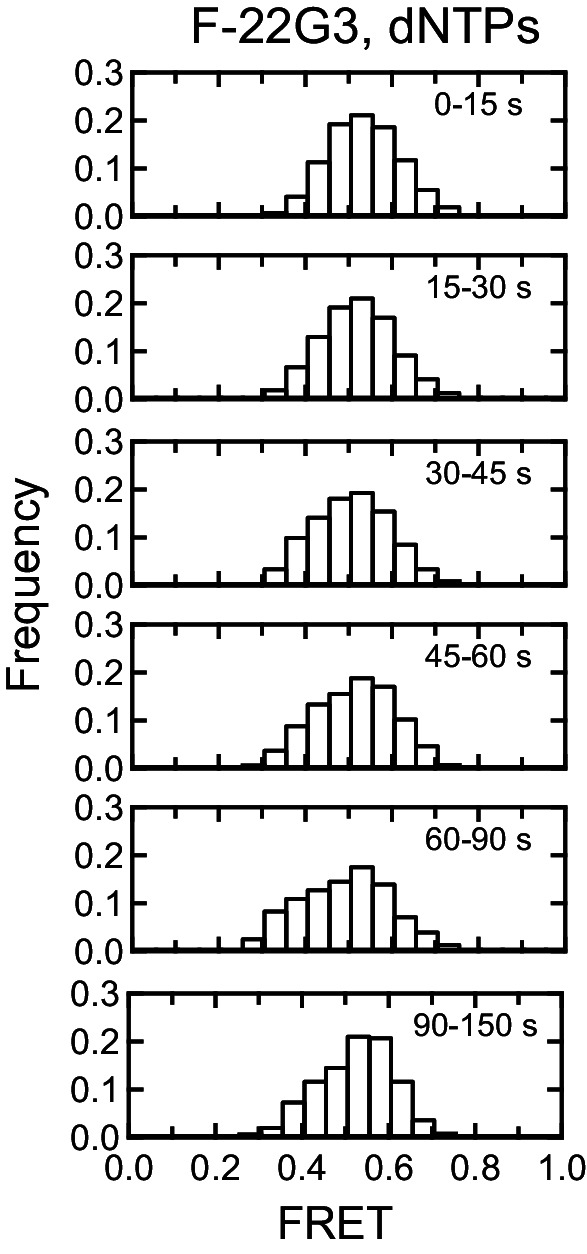
Control for effect of dNTPs on F-22G3 FRET.Histograms showing changes in FRET values of a population of F-22G3 molecules in the presence of dNTPs but absence of telomerase over 150 s, binned into 15–60 s time intervals. n = 44 molecules.